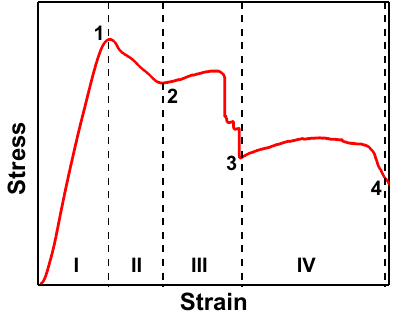
Figure 7: The typical stress – strain curve and crack propagation zone of CFRP composite subjected to three - point